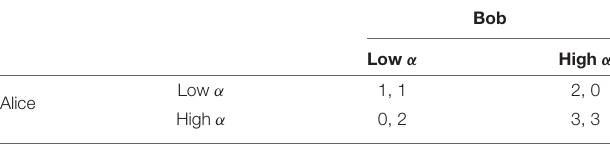
TABLE 4 | Structure of the game faced by both Alice and Bob.